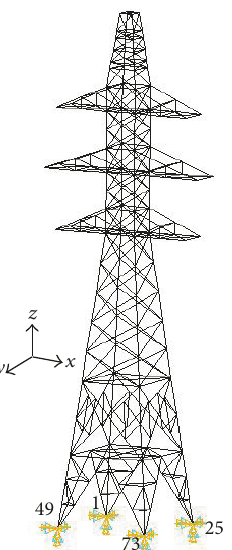
Figure 14: FEM model